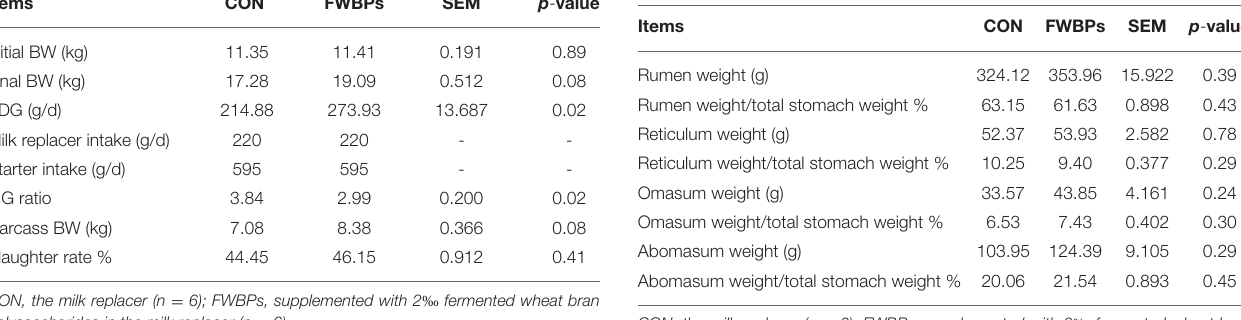
TABLE 4 | Effects of FWBPs on the rumen, reticulum, omasum, and abomasum weight of early-weaned lambs.